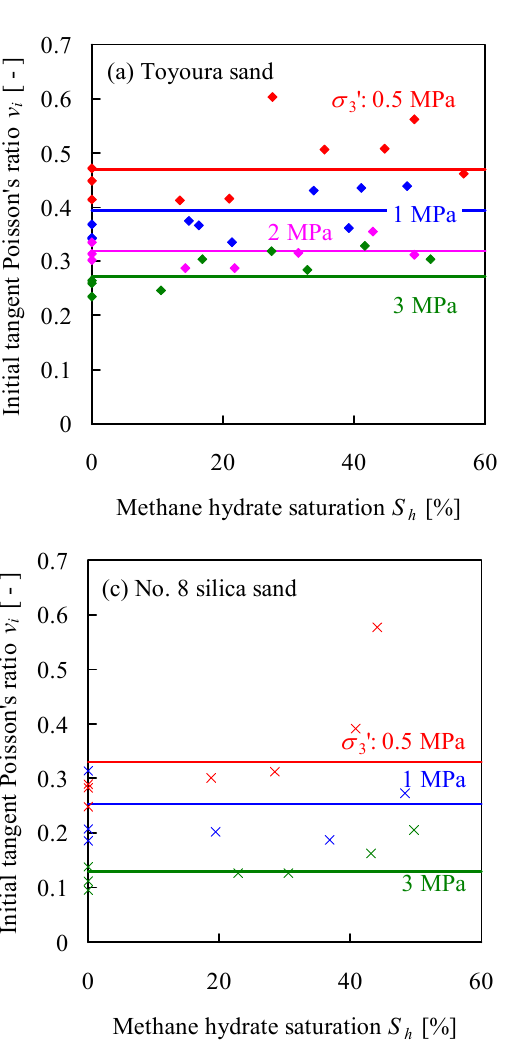
versus methane hydrate saturation S i